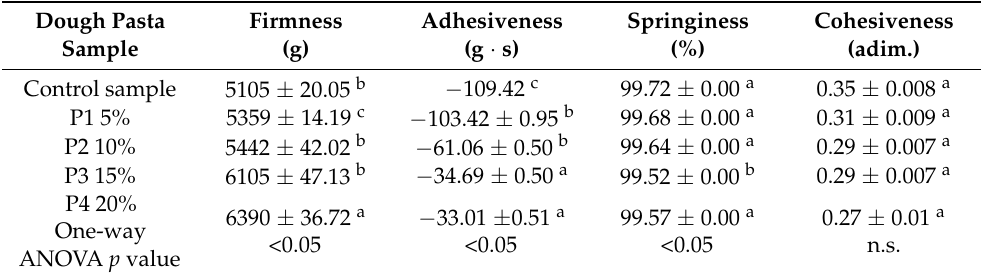
Table 2. Pasta dough textural parameters.